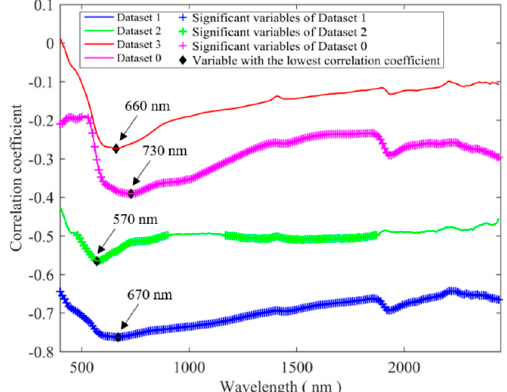
Figure 3. Correlation coe ffi cient curves calculated between the raw visible and near-infrared (VIS-NIR) spectra and soil organic carbon (SOC) for four datasets. The blue line, green line, red line, and magenta line refer to correlation coe ffi cient curves for Dataset 1, Dataset 2, Dataset 3, and Dataset 0, respectively. The blue ‘ + ’, green ‘ + ’, and magenta ‘ + ’ symbols refer to locations of VIS-NIR spectral variables having significant correlation for Dataset 1, Dataset 2, and Dataset 0, respectively (at a significance level of 0.05). The ‘ (cid:169) ’ symbol refers to the location of spectral variables having the lowest correlation coe ffi cient.